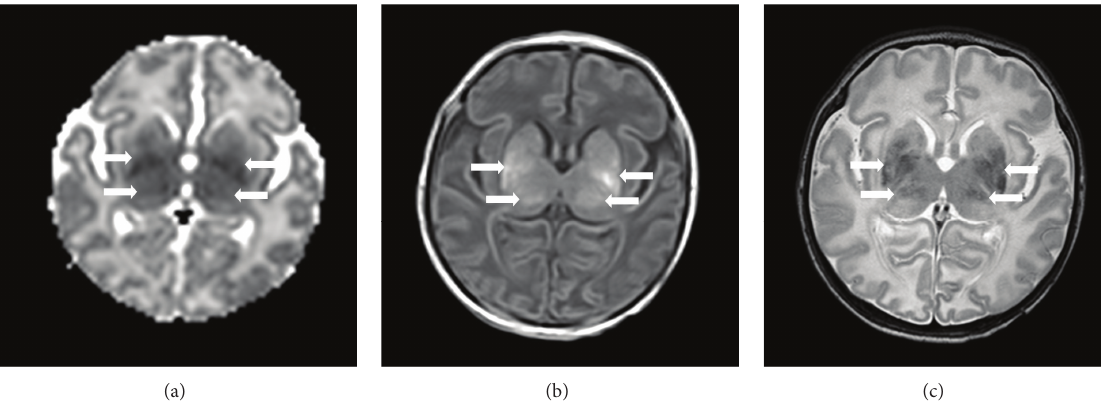
Figure 2: Brain MRIs of a term asphyxiated newborn treated with hypothermia, performed on day 2 of life (a) and on day 9 of life (b-c). (a) The apparent diffusion coefficient map on day 2 of life for this patient shows a restricted diffusion involving the thalami and lentiform nuclei (arrows). (b and c) The T1-weighted imaging (b) and T2-weighted imaging (c) confirm the injury within the thalami and lentiform nuclei